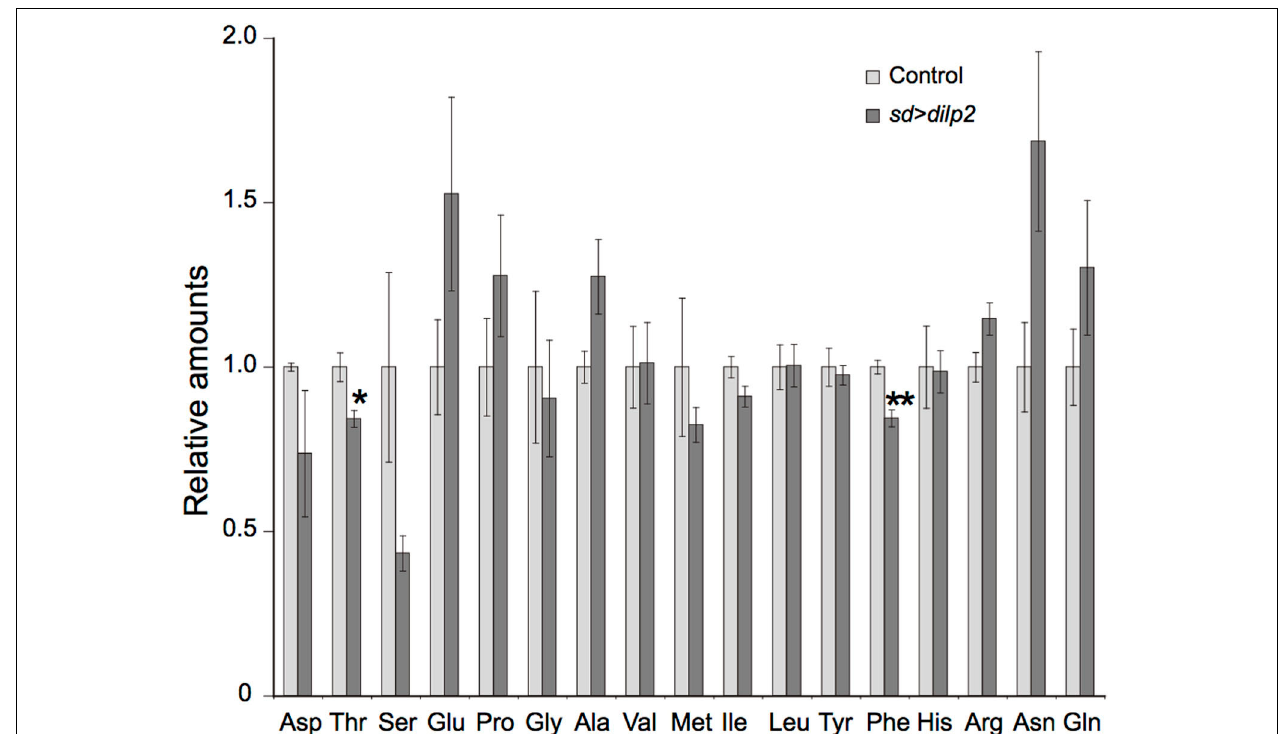
FIGURE 11 | Amino acid content in dilp2 -overexpressing flies. A free amino acids in the adult flies were quantified by using an LC-MS/MS in positive mode. Relative amounts of each amino acid in sd > dilp2 flies were calculated based on those in the sd > RFP